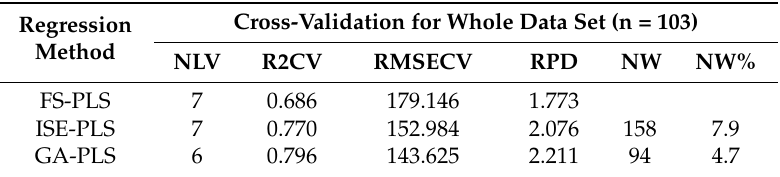
Figure 6. Relationships between observed and predicted values of soil oxalate-extractable P contents using ( a ) FS-PLS, ( b ) ISE-PLS and ( c ) GA-PLS regressions. Table 4. Optimum number of latent variables (NLV), coefficient of determination ( R 2 ), root mean squared errors of cross-validation (RMSECV), and residual predictive values (RPD) from FS-PLS, ISE-PLS and GA-PLS models with selected number of wavebands (NW) and their percentages of the full spectrum (NW%). NW% = NW / 2001 bands ×